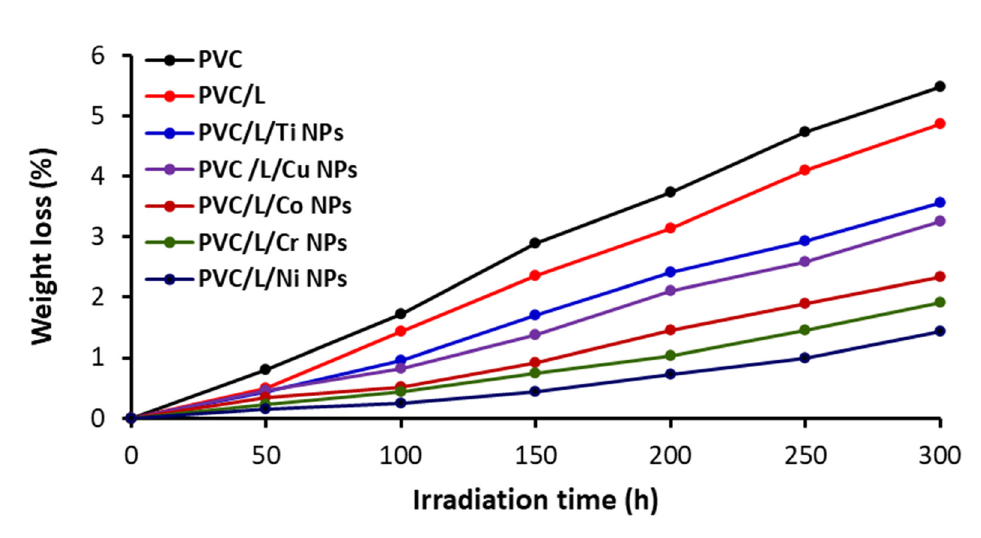
Figure 5. The weight loss percentage as a function of PVC fi lm UV irradiation